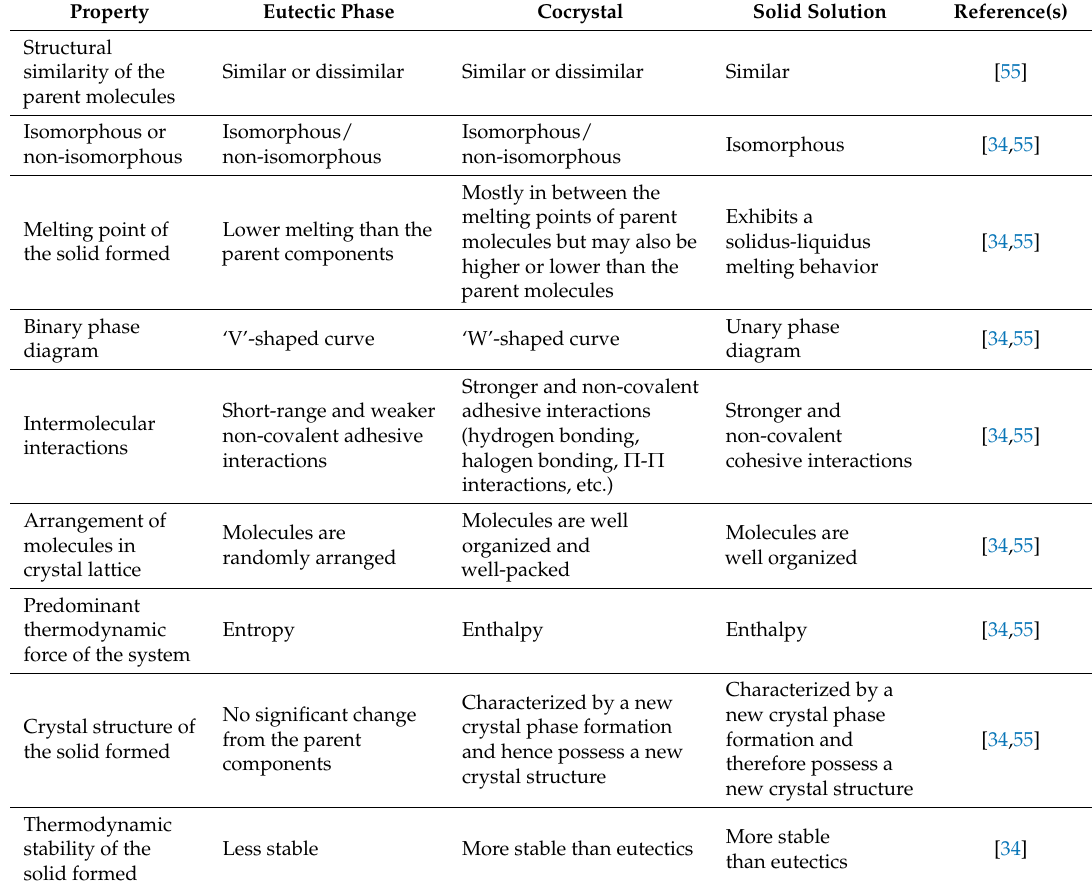
Table 1. Characteristic feature of eutectics, cocrystals and solid